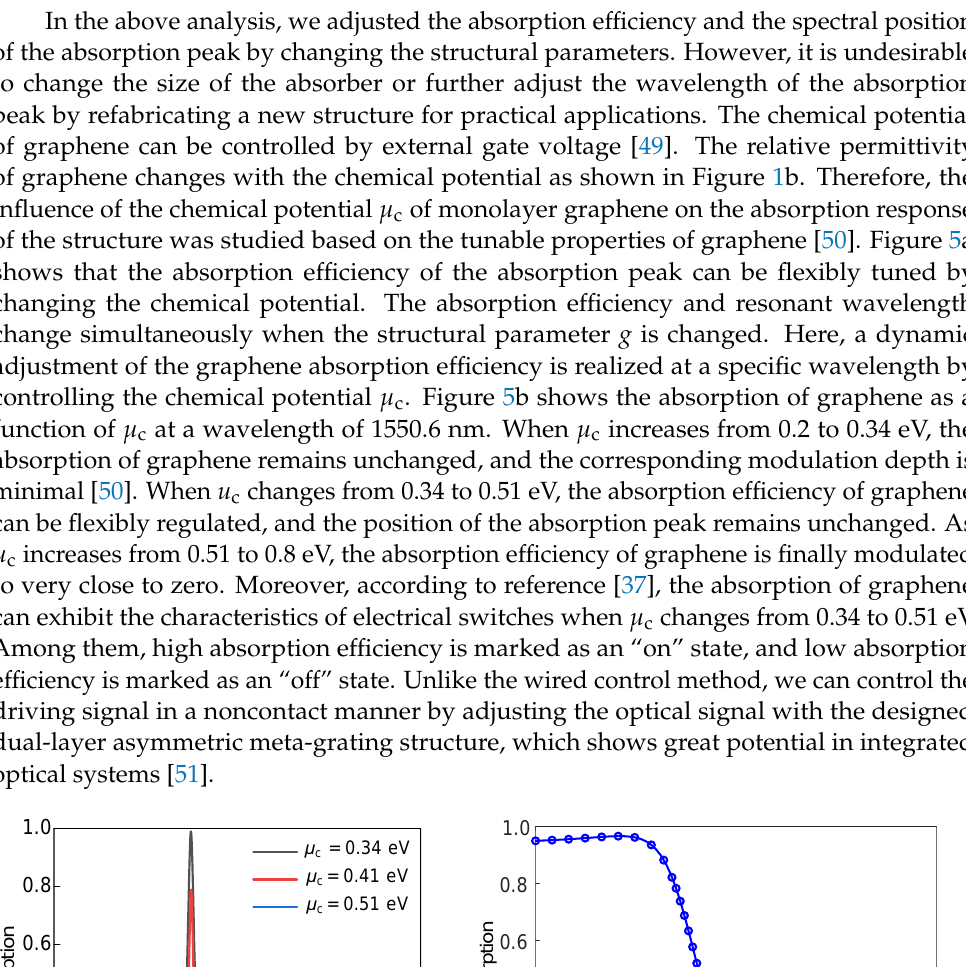
Figure 4. ( a ) Absorption spectra of the proposed structure with different waveguide layer thick- nesses d h . ( b ) Absorption spectra of the proposed structure with different grating periods P .